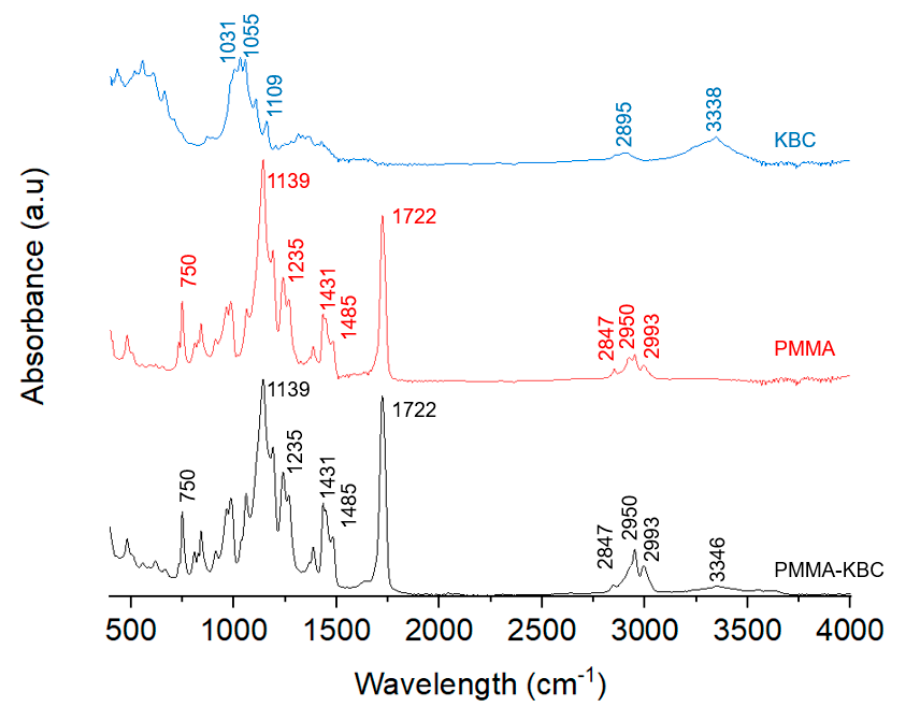
Figure 8. FT-IR spectra of PMMA-KBC (black), PMMA (red), and KBC (blue) indicating the main bands for each of them.